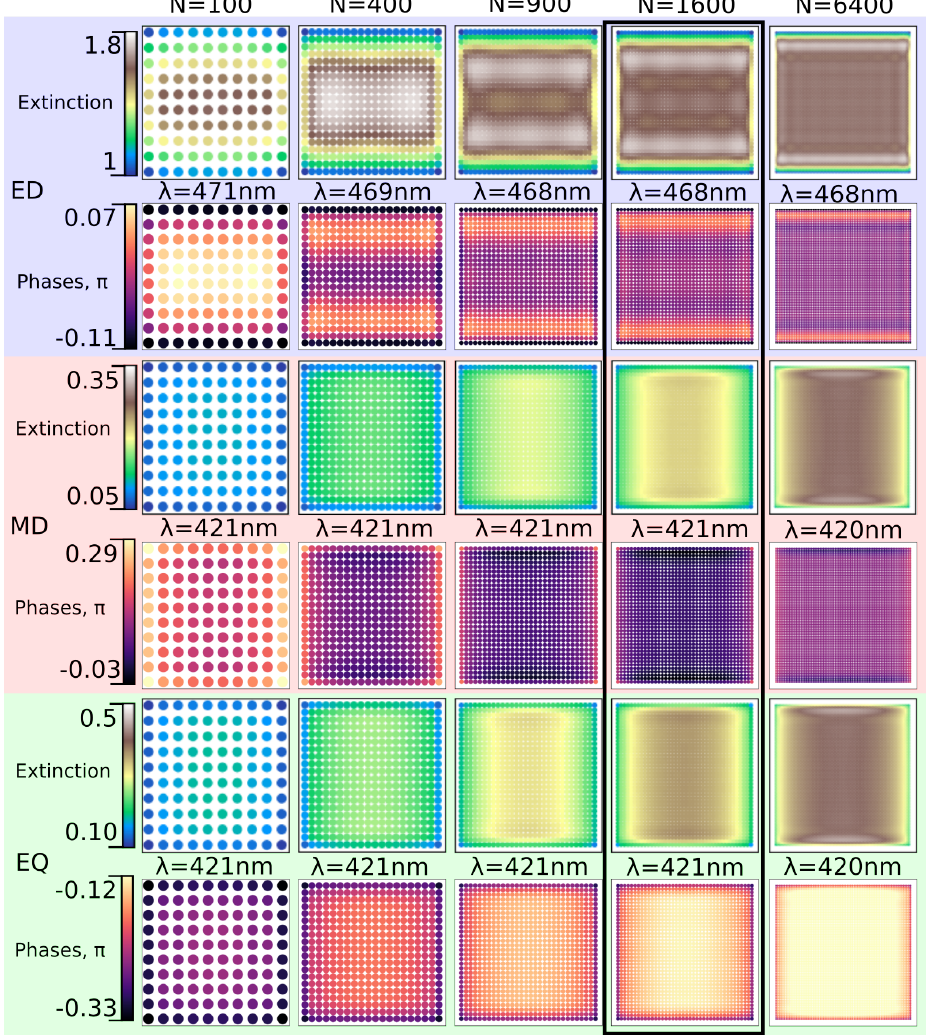
Figure 3. Evolution of the extinction efficiency per NP and scattered wave phases for different N for ED, MD and EQ resonances. Highlighted N = 1600 case corresponds to data shown in Figure